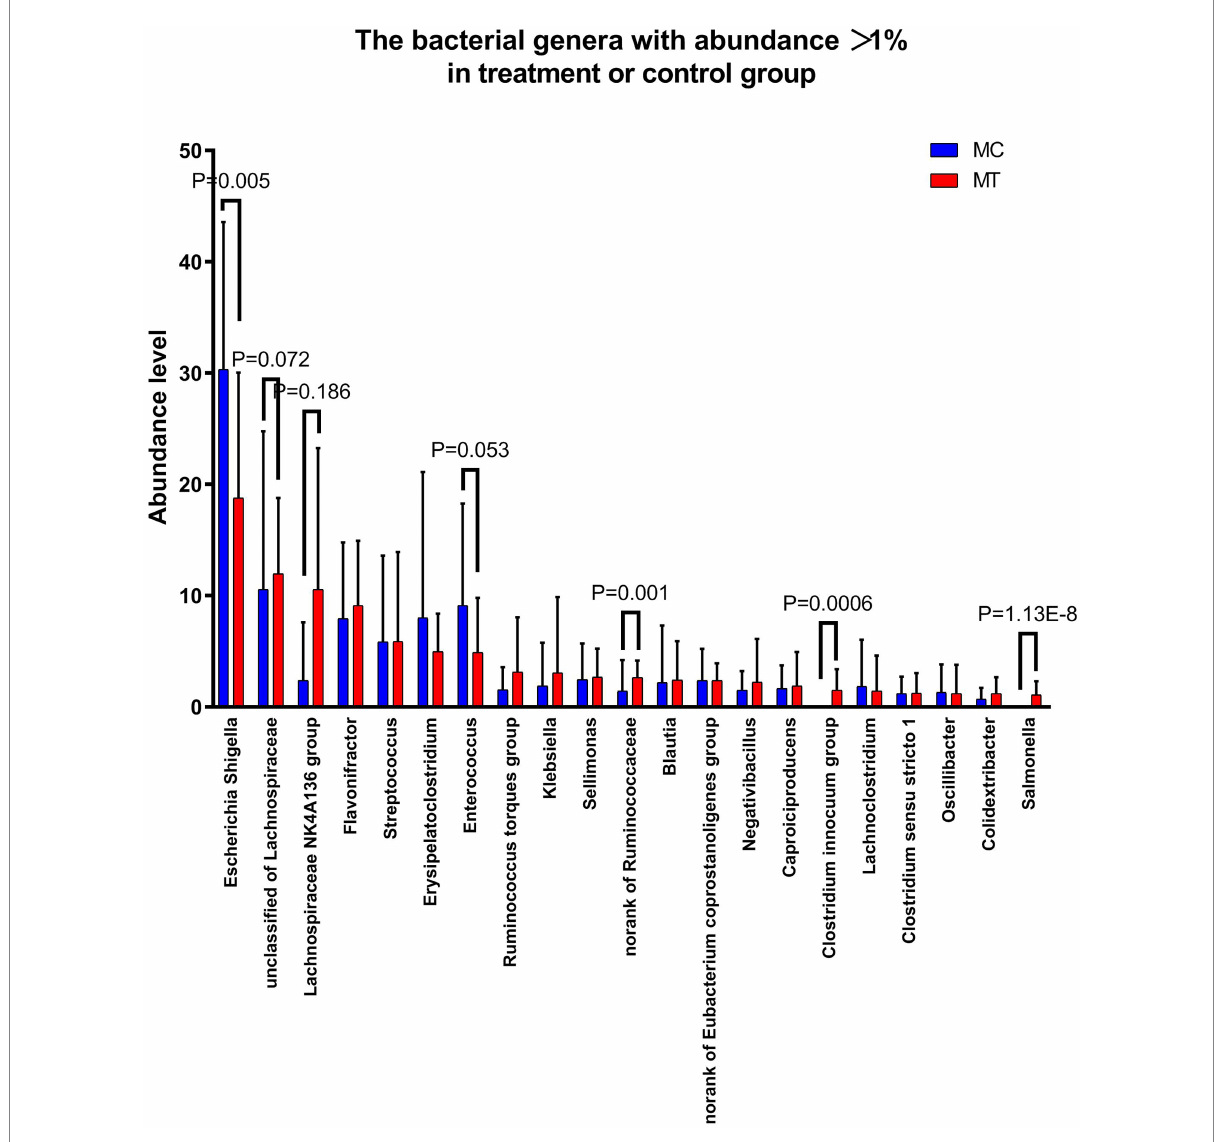
FIGURE 4 The top 21 genera with abundance >1% in treatment or control